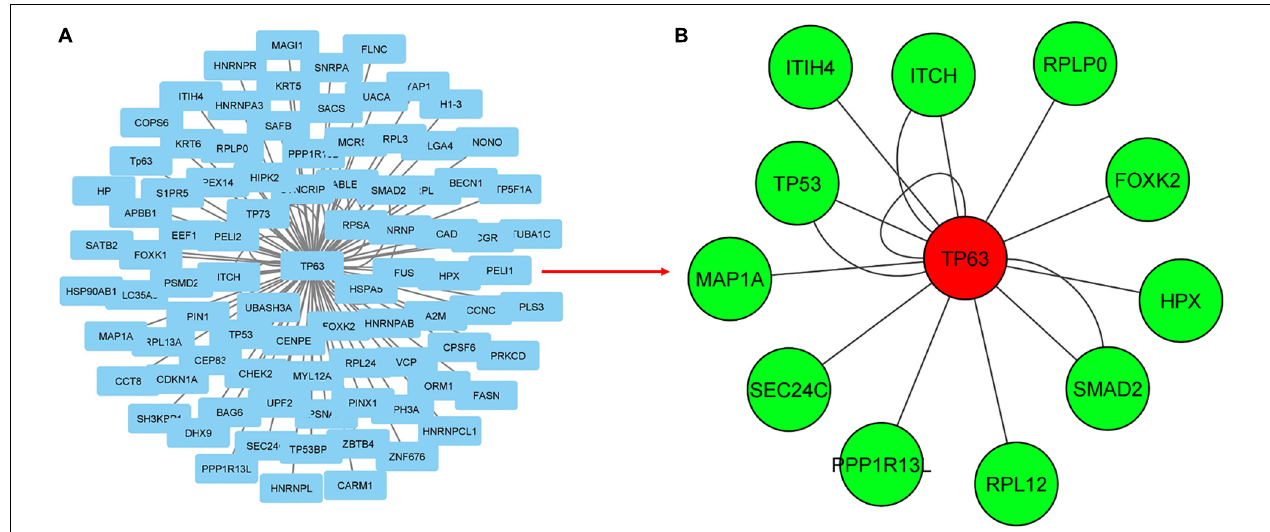
FIGURE 3 | Mapping transcriptome data to UC-specific PPI network for the discovery of subnetworks with KeyPathwayMiner (KPM). (A) PPI network for UC obtained from the PSICQUIC database, including 88 proteins and 100 interactions. (B) Mapping transcriptome data to UC-specific PPI network reveals a module containing 13 proteins and 16 interactions. Green and red colored nodes correspond to the DEGs in the expression dataset and the genes that are not significantly different from the healthy samples, respectively, whereas circle-shaped nodes indicate they were mapped to both of the expression datasets.